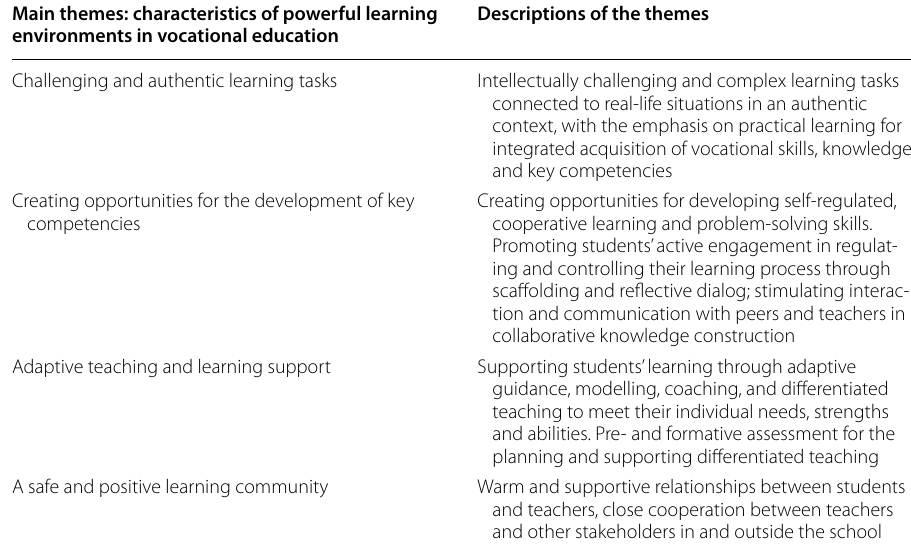
Table 1 Coding template based on characteristics of the model of powerful learning environments in vocational education (Placklé et al. 2014,